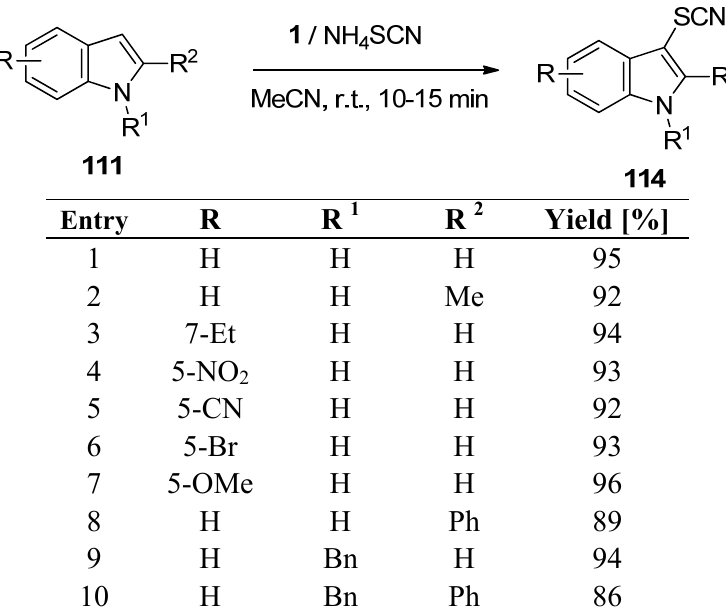
Table 9. Thiocyanation of indole derivatives with ammonium thiocyanate using F-TEDA-BF 4